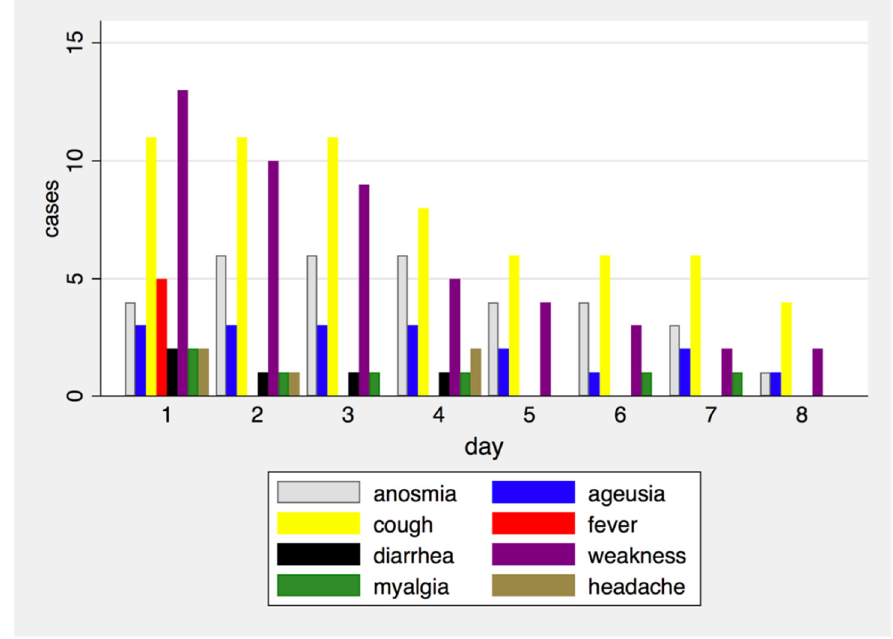
Figure 2. Frequency of symptoms by study day.